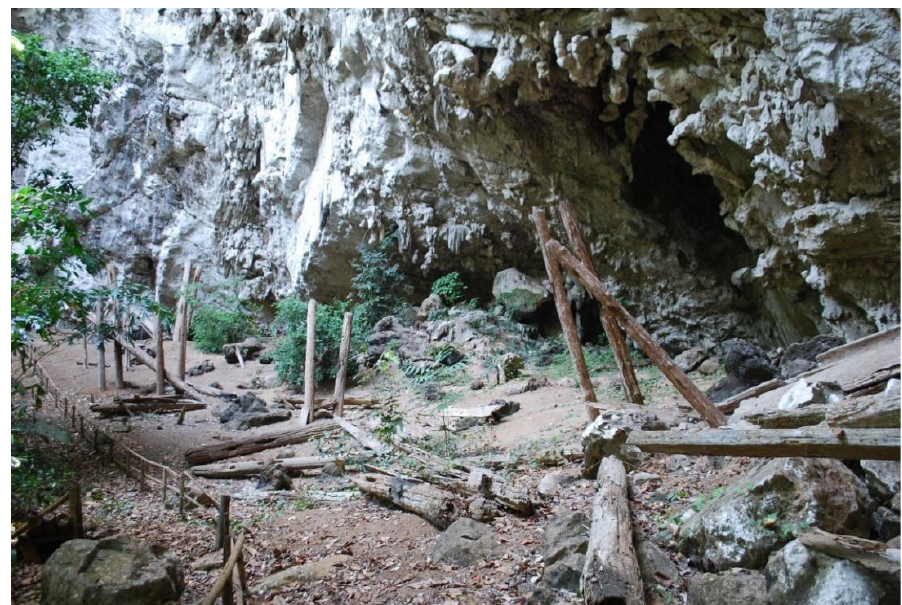
Figure 3. Ban Rai Rockshelter: view from the northeast wing of the rockshelter.